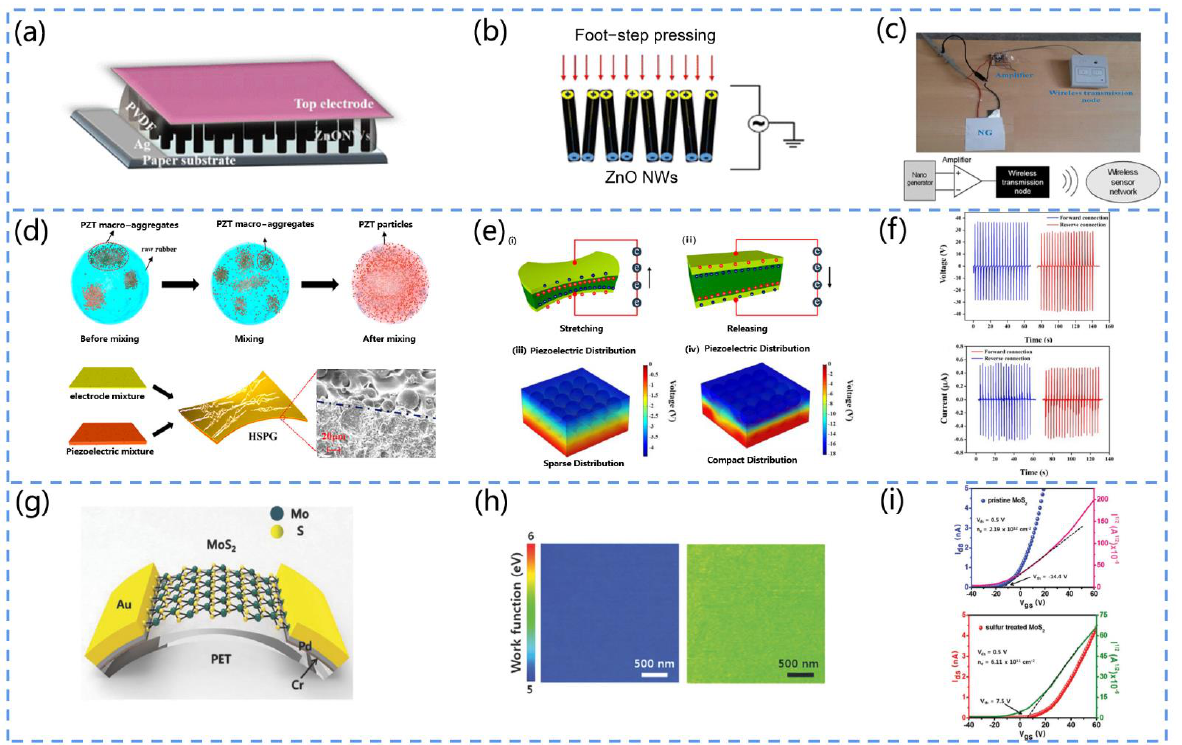
Figure 4. ( a ) Structure diagram of the ZnO-based PENG. ( b ) Graph of the voltage profile generated by the PENG under foot pressure. ( c ) The complete operation schematic of the device. Reprinted with permission from [77]. Copyright 2016, SpringerOpen. ( d ) Schematic diagram of the fabrication process and structure of the PZT-based piezoelectric nanogenerator (HSPG). ( e ) Schematic diagram of the operation of the HSPG (i,ii) and the simulation of the piezoelectric potential distribution when the PZT is sparsely or tightly distributed throughout the substrate (iii,iv). ( f ) Plots of the output of the forward- and reverse-connected HSPG. Reprinted with permission from [78]. Copyright 2019, ACS Publications. ( g ) Schematic diagram of the PENG structure based on MoS 2 nanosheets. ( h ) Comparison of the KPFM images of MoS 2 nanosheets and S-treated MoS 2 nanosheets. ( i ) I ds -V gs plots of MoS 2 nanosheets and S-treated MoS 2 . The voltage is shifted and the carrier density is significantly reduced. Reprinted with permission from [80]. Copyright 2018, Wiley Online